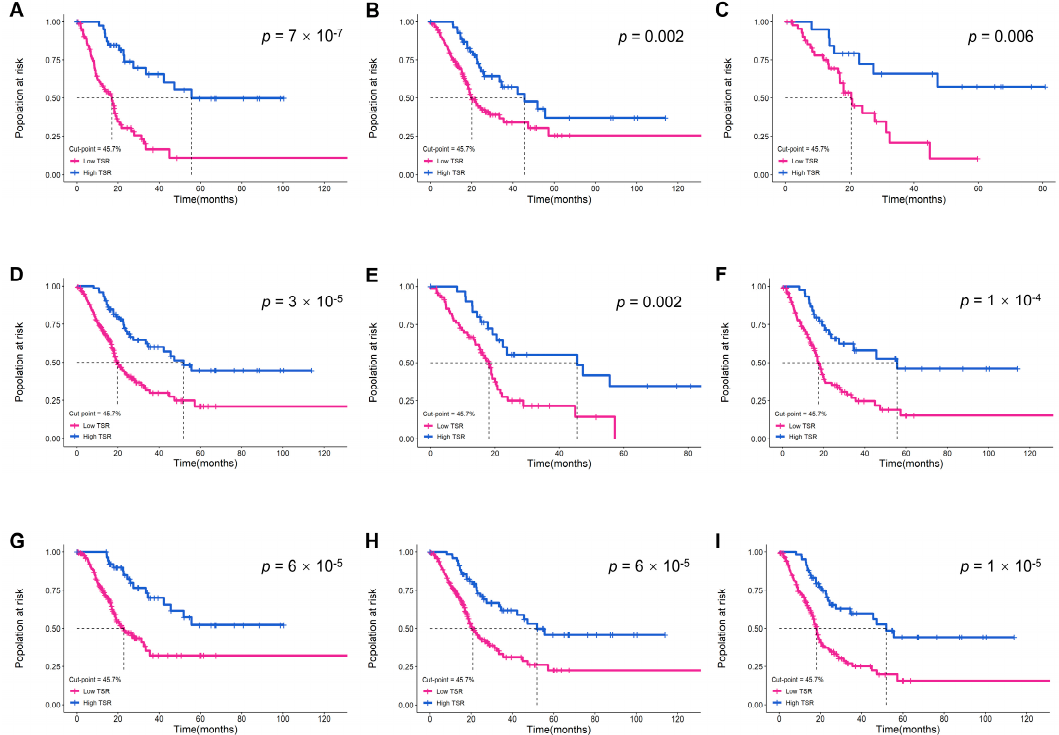
Figure 4. The performance of ML-based TSR with a 45.7% cut-off point in predicting prognosis in the TCGA cohort. Kaplan–Meier survival curves for the following subgroups: ( A ) age ≥ 70; ( B ) male; ( C ) female; ( D ) high histologic grade; ( E ) lymphovascular invasion; ( F ) pT stage 3–4; ( G ) pN stage 0–1; ( H ) pM stage 0; ( I ) pTNM stage III-IV.